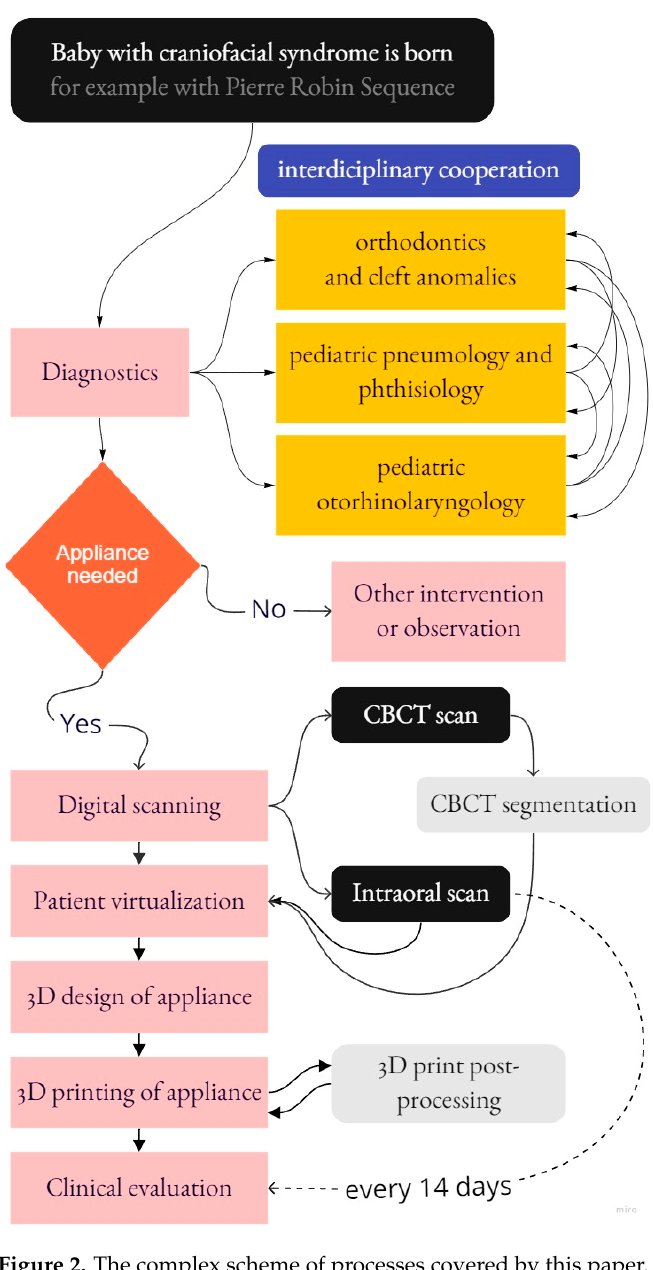
Figure 2. The complex scheme of processes covered by this